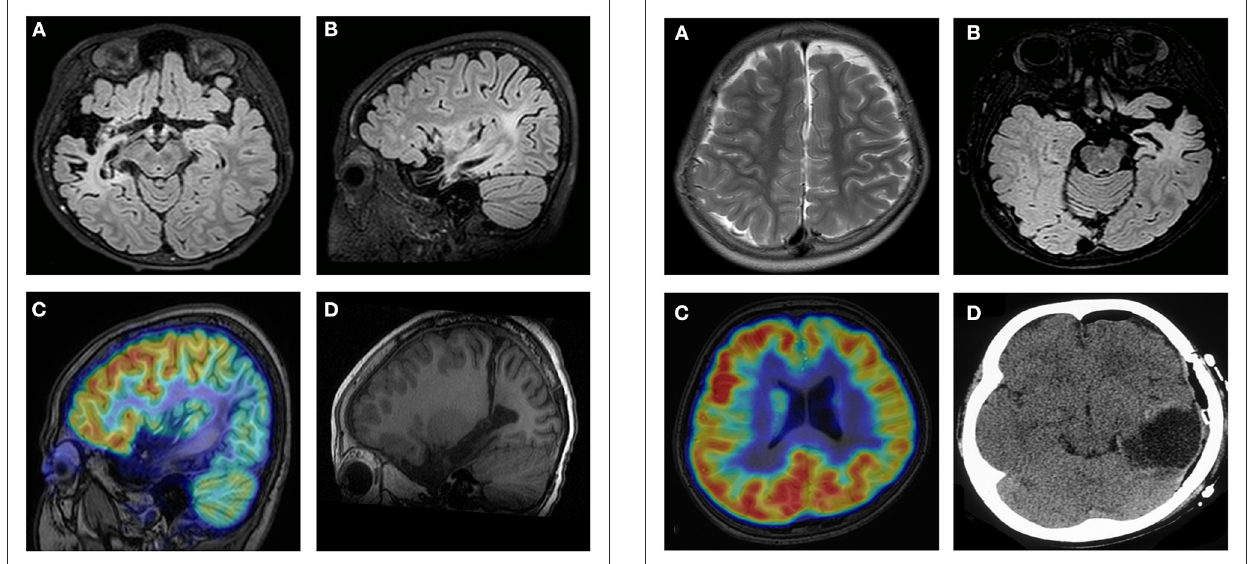
FIGURE2 Neuroimaging data of case 1. MRI reveals encephalomalacia in the right temporal lobe (A) . Abnormal signals are observed in the right parietal and occipital lobes (B) . PET-MRI Coregistration shows hypometabolism in the temporal, parietal and occipital lobes (C) . Postoperative MRI shows disconnection of the temporo-parieto-occipital lobes (D) .